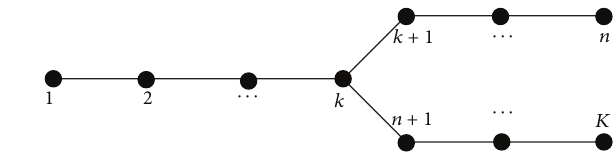
Figure 2: Competition of players on a